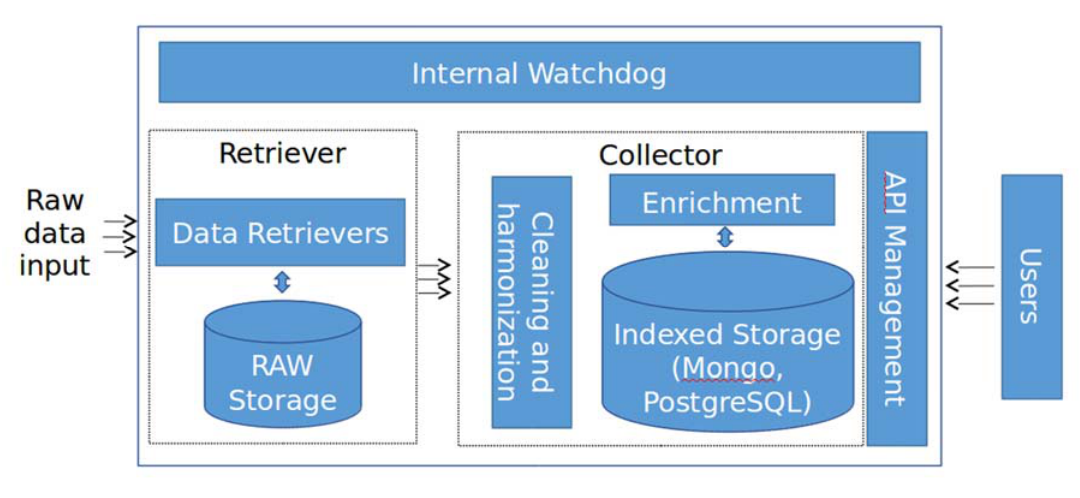
Figure 1. The architecture of our system for IoT middleware for water